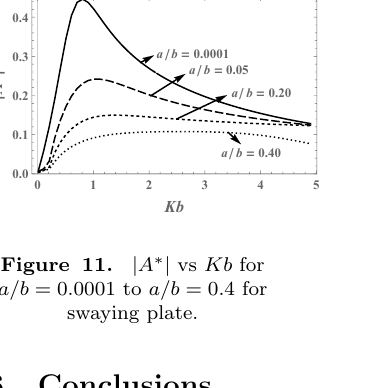
Figure 11. | A ∗ | vs Kb for a/b = 0 . 0001 to a/b = 0 . 4 for swaying plate.